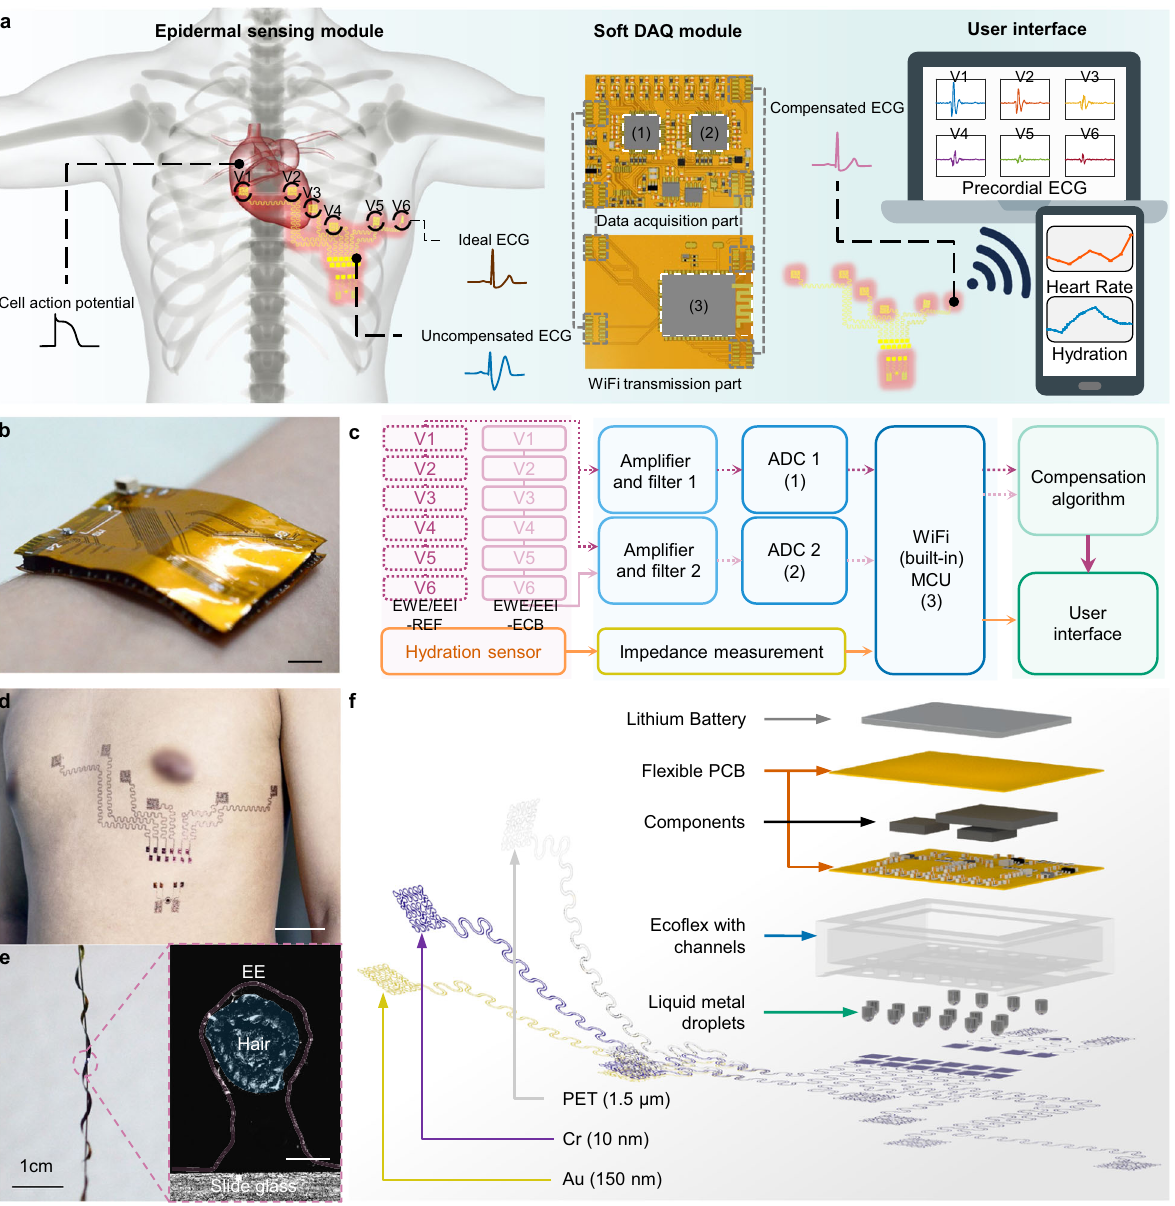
Fig. 1 The architecture of the EES. a Schematic illustration of the EES, including the epidermal sensing module, the soft DAQ module, and the user interface. b Wireless DAQ module laminated on the arm. Scale bar, 10 mm. c System-level work fl ow diagram of the EES, showing analog signal acquisition, procession, wireless transmission, compensation algorithm paths from sensor array to the customized user interface (numbers in parentheses indicate the corresponding labeled components in ( a ). d The photograph of a participant wearing the epidermal sensors. Scale bar, 50 mm. e Optical and microscopic images of fi lamentary epidermal sensors wrapped around a hair strand. The scale bars on the left and right panel are 1 cm and 30 μ m, respectively. f Components and interconnections of the